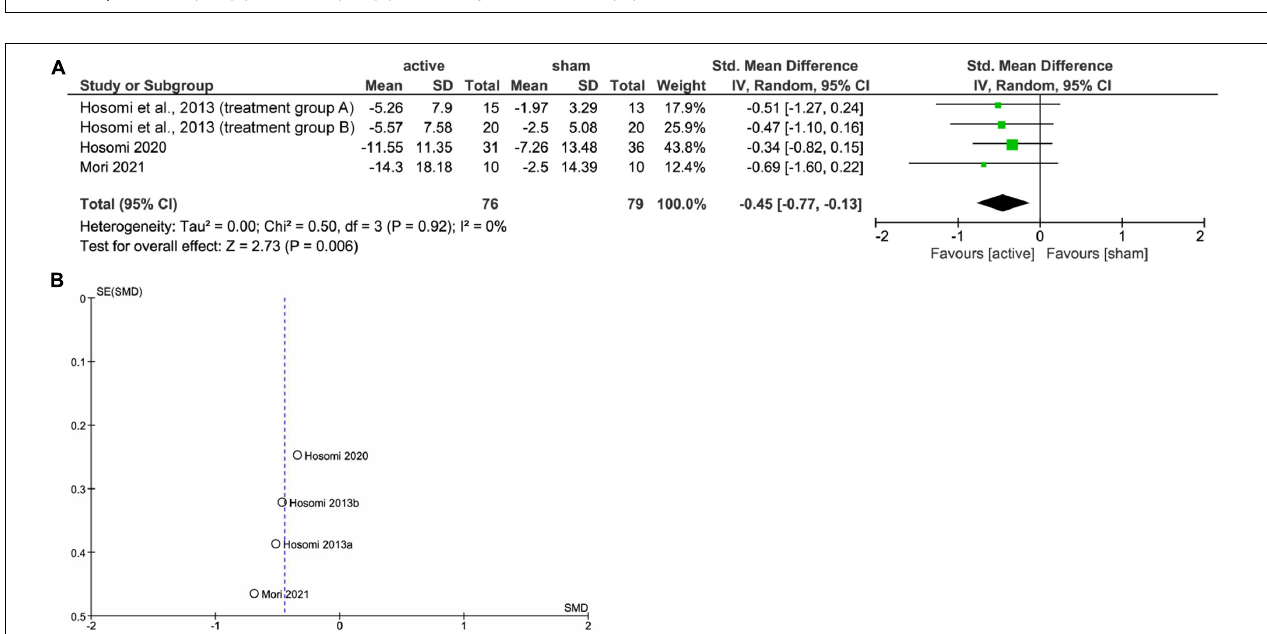
FIGURE 1 | The forest plot (A) and funnel plot (B) of the analysis for the whole population.